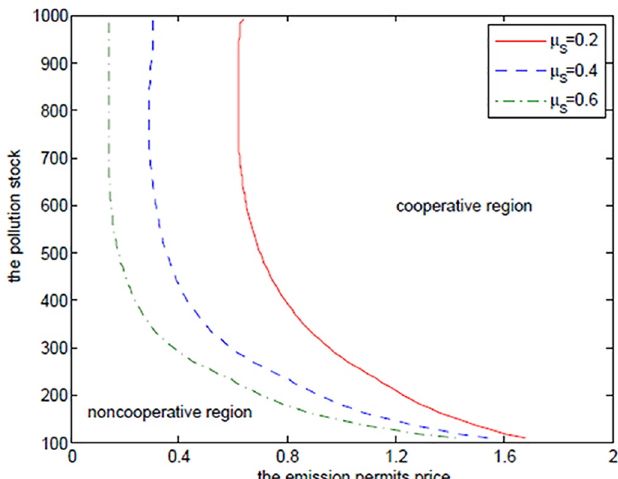
Fig 10. The effects of μ S on the optimal decision